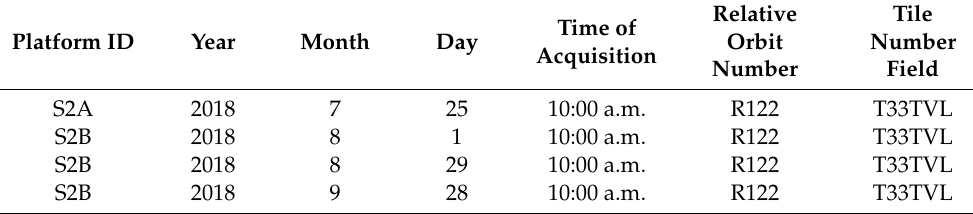
Table 1. Details of Sentinel 2 Level 2A products used in this